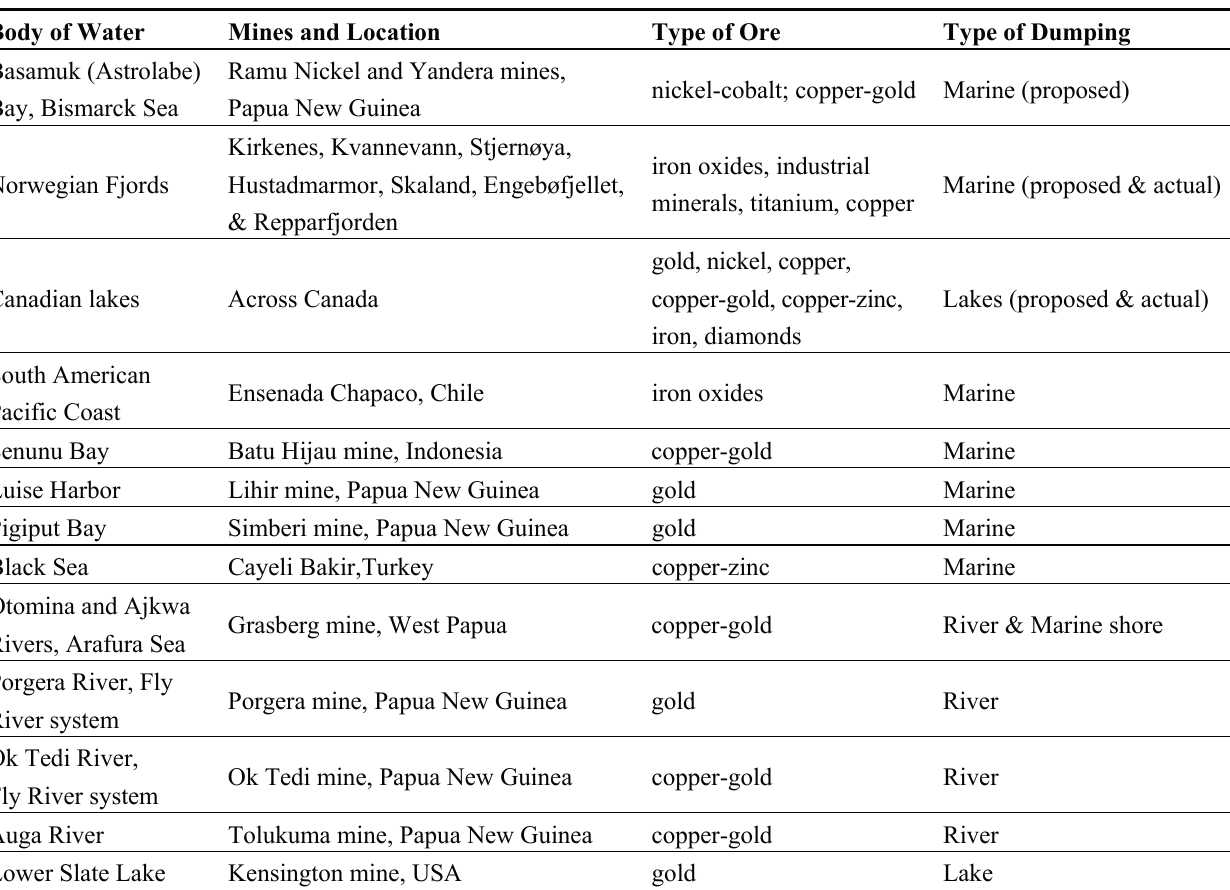
Table 3. Summary of the project and sites where tailings disposal into water bodies occurs (lakes, rivers and the sea (STD)); Adapted from